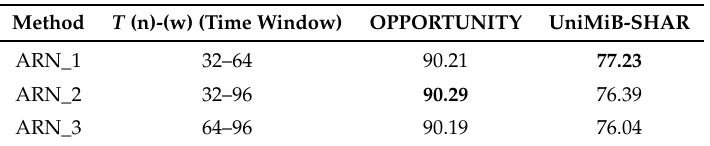
Table 8. Weighted F 1 -score performances comparison of ARN with the combinations of different slide window lengths on the OPPORTUNITY and UniMiB-SHAR datasets. (n) and (w) denote the narrow and wide paths,